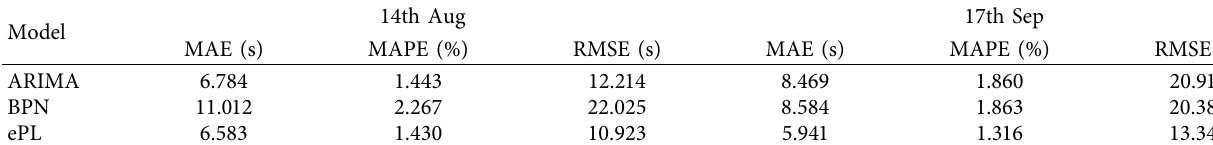
Figure 6: The workflow chart of a single ePL predictor. Table 1: Modelling performance of one-step-ahead travel time forecasting.